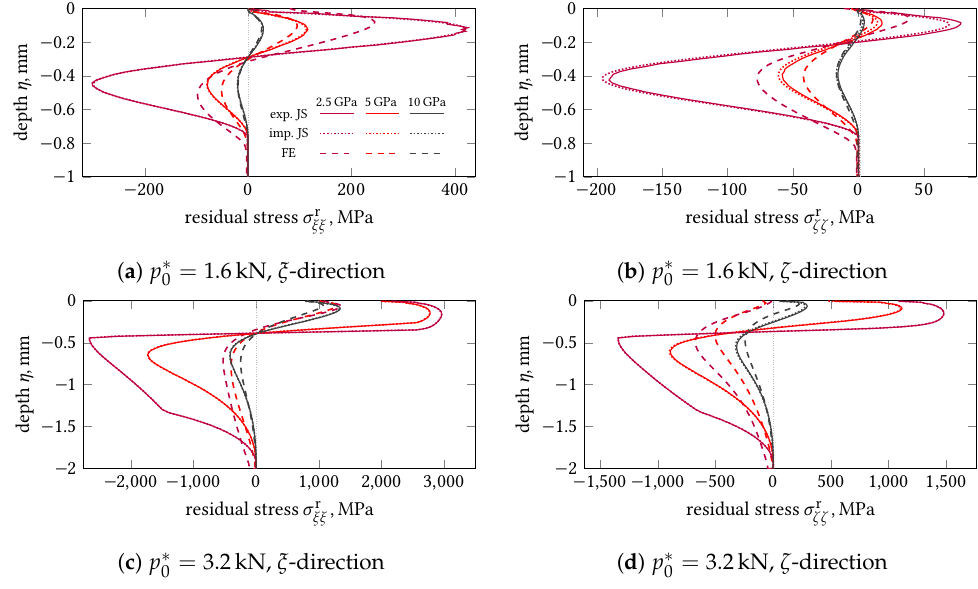
Figure 13. Residual stresses computed by the JS method vs. the results computed by FE analysis for various values of the plastic-hardening parameter h and both considered load levels p ∗